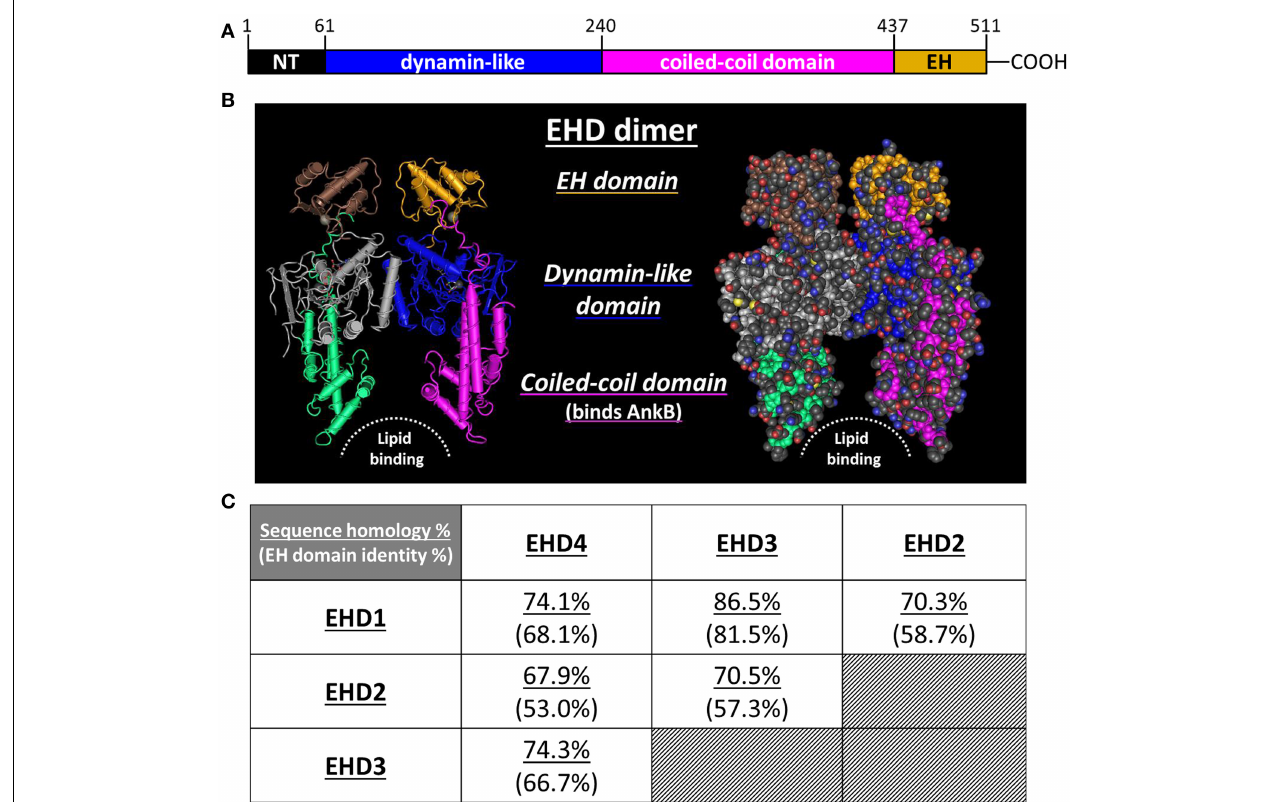
FIGURE 1 | EHD protein structure and sequence homology. (A) Each EHD protein is contains an N-terminal region (NT), a dynamin-like domain, a coiled-coil domain, and a C-terminal EH domain. Typically, the EH domain mediates protein:protein interactions with EHDs. (B) Ribbon and space filling models of an EHD protein, based on the known crystal